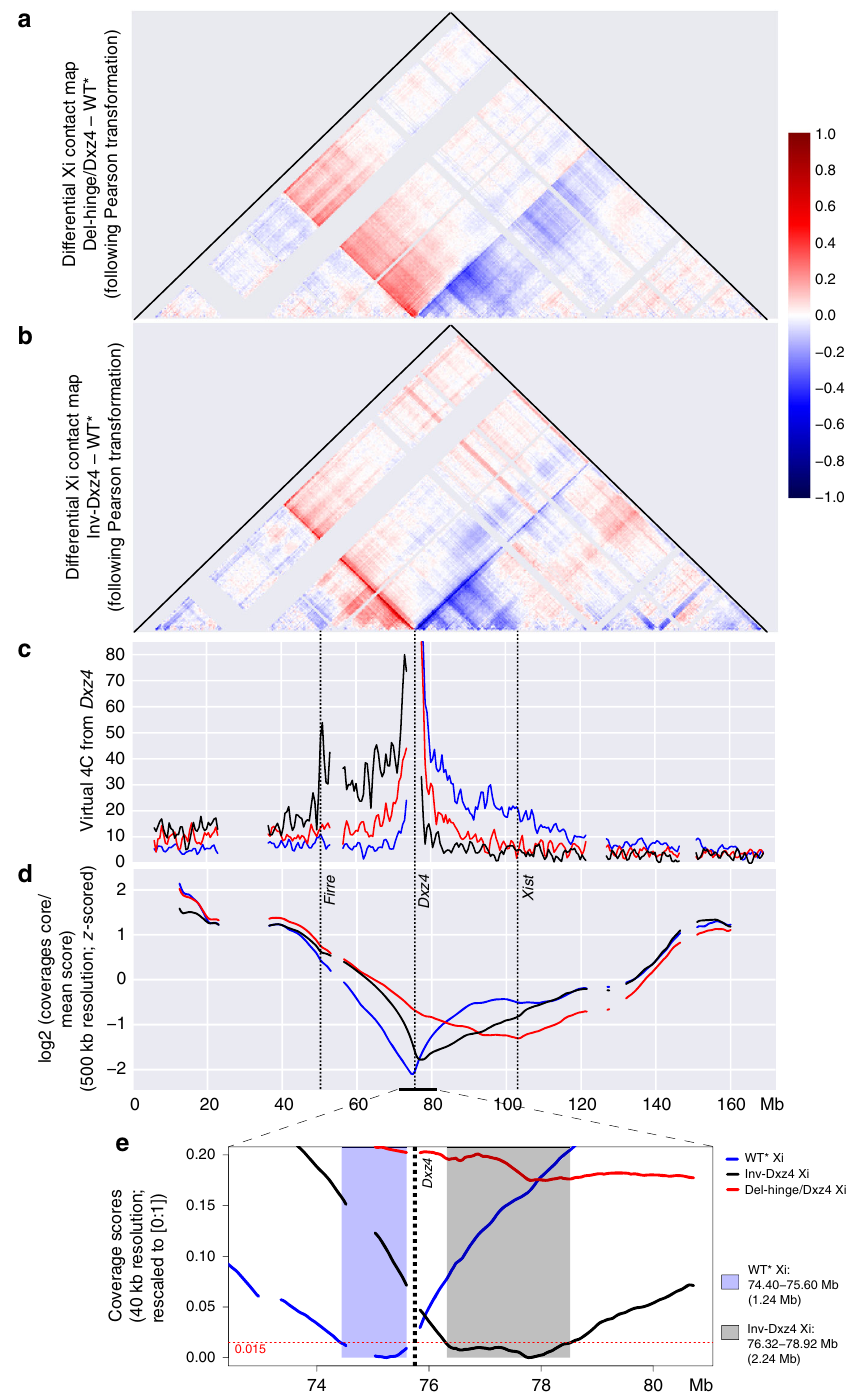
Fig. 3 Unidirectional disruption of contacts on the Xi after Dxz4 deletion or inversion. a Differential contact map based on Pearson correlation-transformed data at 500 kb resolution to highlight differences between Del-hinge/Dxz4 Xi and WT* Xi (loss or gain of contacts in the Del-hinge/Dxz4 versus WT* appear blue or red, respectively). The color scale shows differential Pearson correlation values. See Supplementary Fig. 3e, f for comparison with differential contact maps based on untransformed count data. b As in a to highlight differences between Inv-Dxz4 Xi and WT* Xi. See Supplementary Fig. 3g, h for comparison with differential contact maps based on untransformed count data. c Virtual 4C plots derived from Hi-C data at 500 kb resolution using a 500 kb region around Dxz4 as the viewpoint on the Xi in WT* (blue), Del-hinge/Dxz4 (red), and Inv-Dxz4 (black). Y -axis (contact counts) limited to 20% of maximum. The positions of Firre , Dxz4 , and Xist are indicated. See additional 4C analyses in Supplementary Fig. 3i. d Standardized coverage score pro fi les at 500 kb resolution for the Xi in WT* (blue), Del-hinge/Dxz4 (red), and Inv-Dxz4 (black). The positions of Firre , Dxz4 , and Xist are indicated. See additional analysis of coverage scores for Xi and Xa in all cell lines in Supplementary Fig. 4a-d. e Coverage scores (rescaled to [0; 1]) at 40 kb resolution within a 8 Mb region around Dxz4 for the Xi. The light blue background highlights the Xi boundary region of minimal interaction in WT* based on a threshold of 0.015 (horizontal red dashed line). The light gray background shows how this region is shifted to the right in